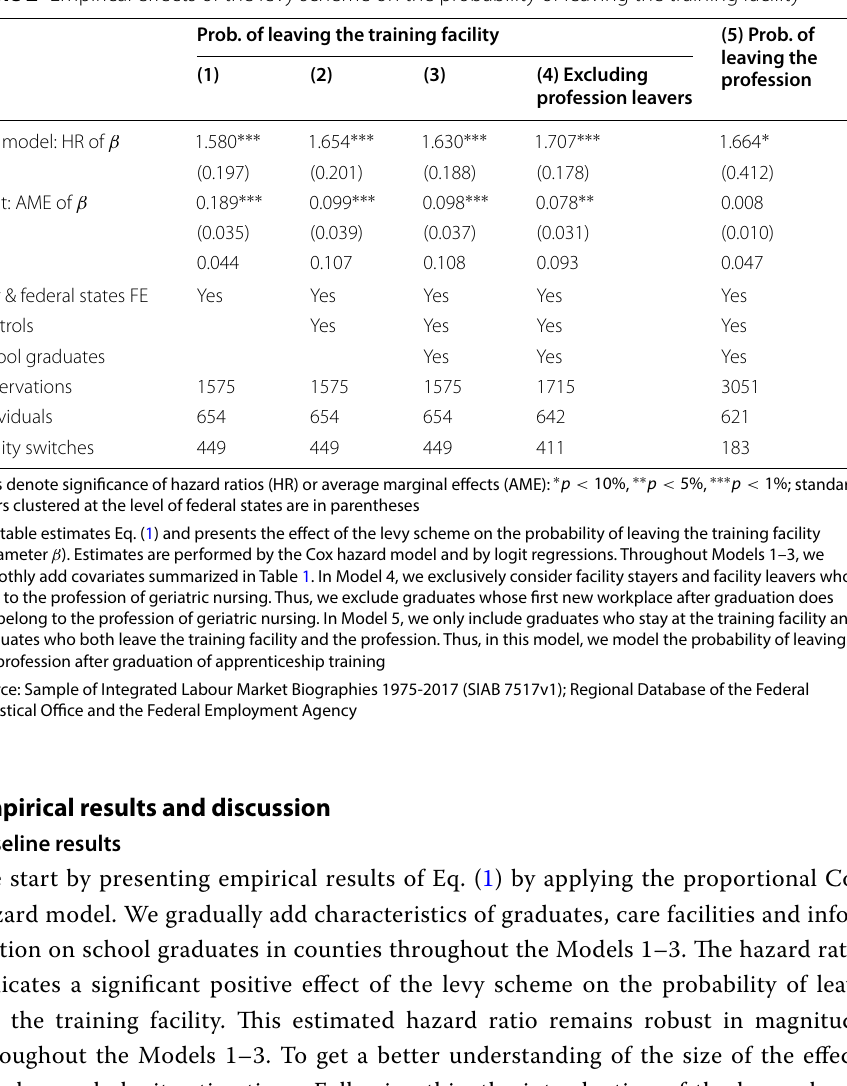
Table 2 Empirical effects of the levy scheme on the probability of leaving the training facility